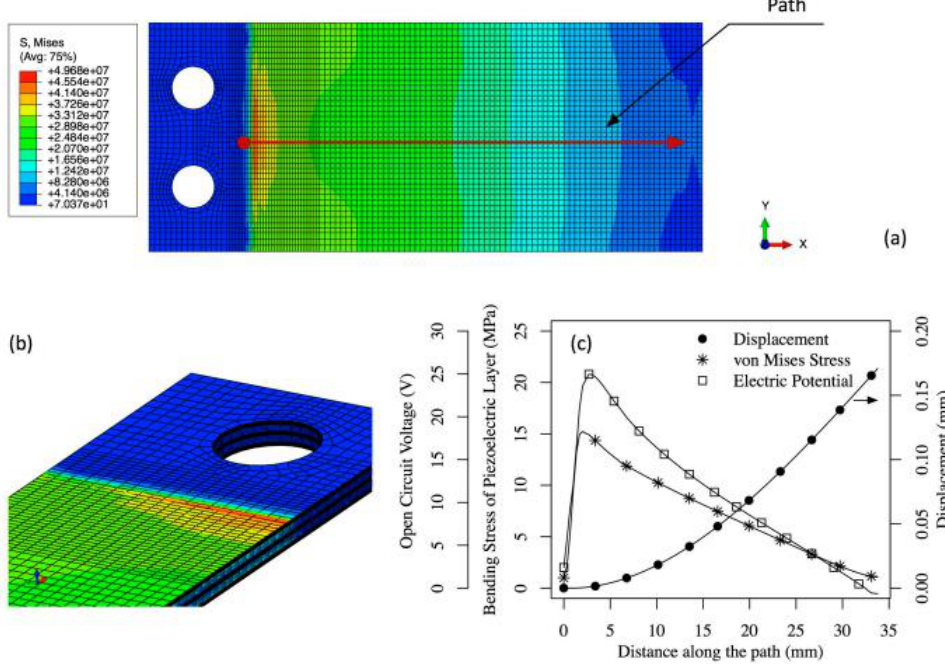
Figure 13. The von Mises spread of stress (MPa) of the armored (2 mil steel) QuickPac (QP21B) leading stainless steel sheet: ( a ) sectional view; ( b ) at point force of 1 N; ( c ) displays curved stress, pointer movement, and the top piezoelectric surface of QP21B’s open-circuit voltage using the route illustrated in ( a )